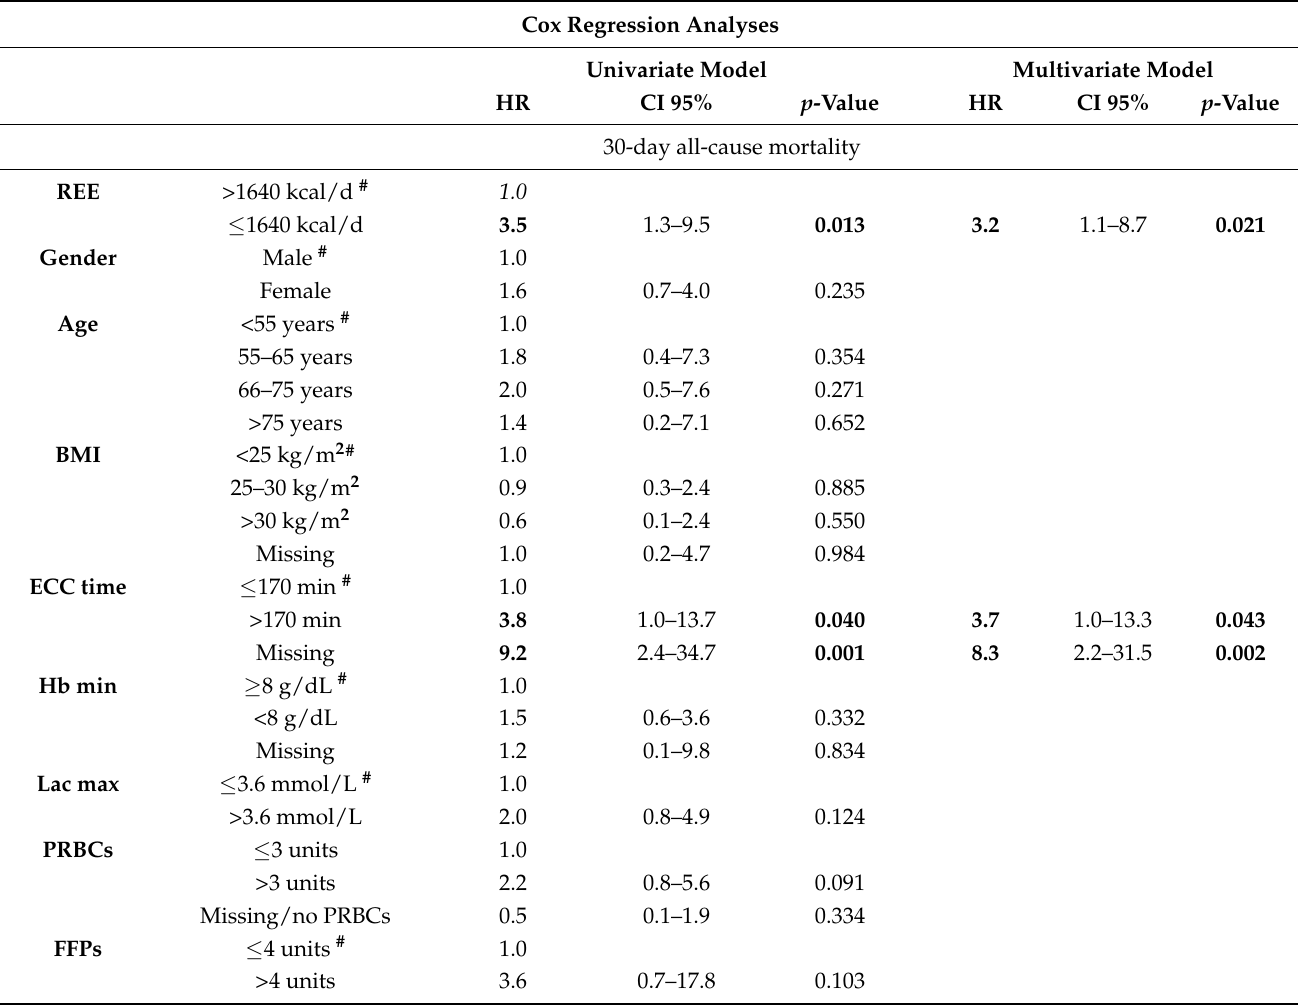
Table 3. Univariate and multivariate cox regression analyses for REE after 30 days, 1 year and 6 years post cardiac